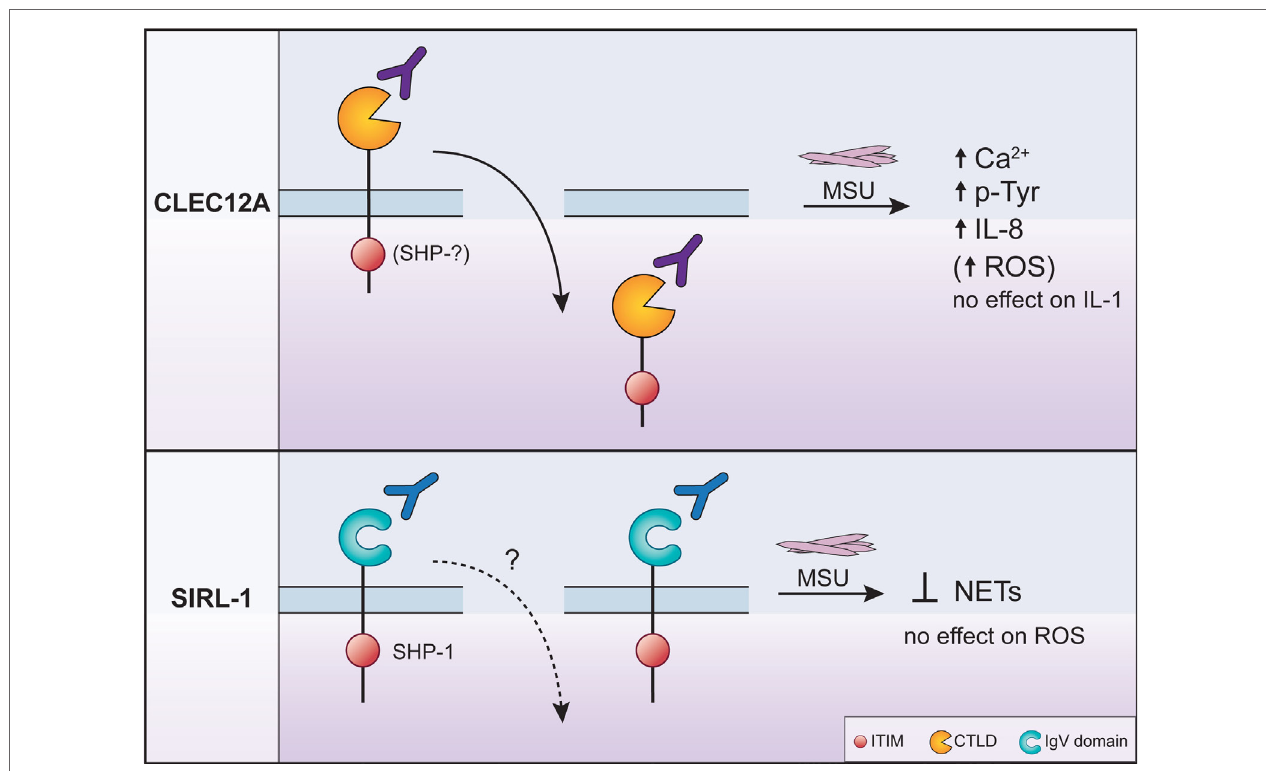
FigURe 1 | The regulation of monosodium urate crystal (MSU)-induced neutrophil activation by CLEC12A and SIRL-1 after engagement with specific antibodies. The engagement of CLEC12A on the surface of human neutrophils with a specific antibody (50C1) induces its internalization ( solid arrow pointing downwards ) resulting in the enhancement of the signaling events and effector functions shown in the figure. The phosphatases that interact with the immunoreceptor tyrosine- based inhibitory motif (ITIM) of CLEC12A in primary cells remain unknown ( top panel ). By contrast, the ligation of SIRL with the anti-SIRL-1 antibody inhibits neutrophil extracellular trap (NET) formation. In primary cells, the ITIM of SIRL-1 interacts with SHP-1. The MSU-induced responses that are not regulated by either receptor are also shown and underscore the specificity of inhibitory receptor function. The anti-SIRL-1 antibody has therapeutic potential since it inhibits NET